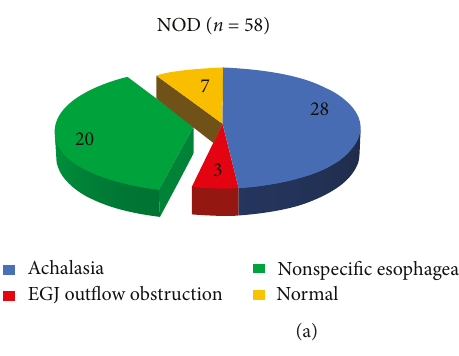
Figure 1: Characteristics of nonobstructive dysphagia (NOD) patients. (a) In a total of 58 patients, 28 (48.3%) patients were diagnosed with achalasia, 3 (5.2%) patients with EGJ out fl ow obstruction, and 20 (34.5%) with nonspeci fi c esophageal motility disorders, and 7 (12.1%) patients were normal. (b) Of 20 nonspeci fi c esophageal motility disorders patients, 3 patients had fragmented peristalsis, 3 patients had distal esophageal spasm, 2 patients had hypercontractile esophagus, and 12 patients had ine ff ective esophageal motility.